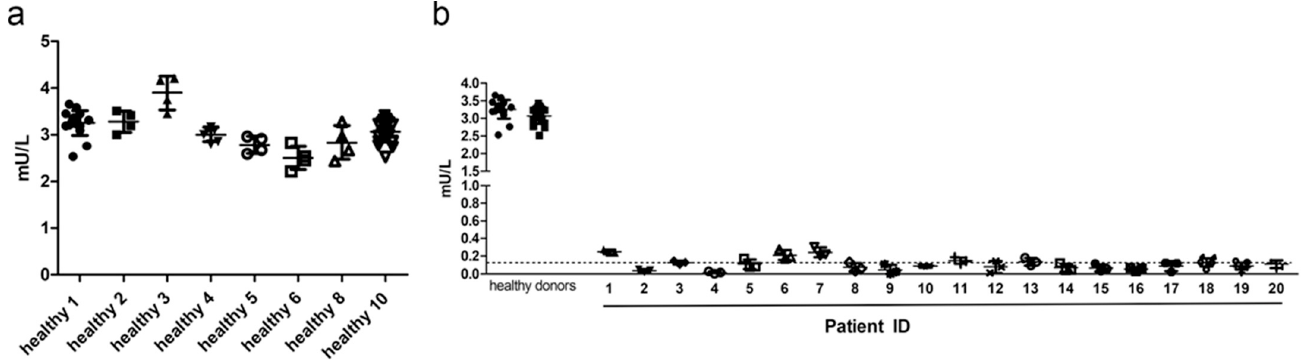
Figure 4. Between-run precision. ( a ) Between-run precision of the AGA activity assay was assessed with serum samples of 8 healthy donors. Each symbol represents one independent measurement out of at least 4 experiments. ( b ) Between-run precision of the AGA activity assay in AGU patient sera. Samples from 20 AGU patients were assessed by three independent experiments. The data for two healthy donors from panel ( a ) are shown for comparison.